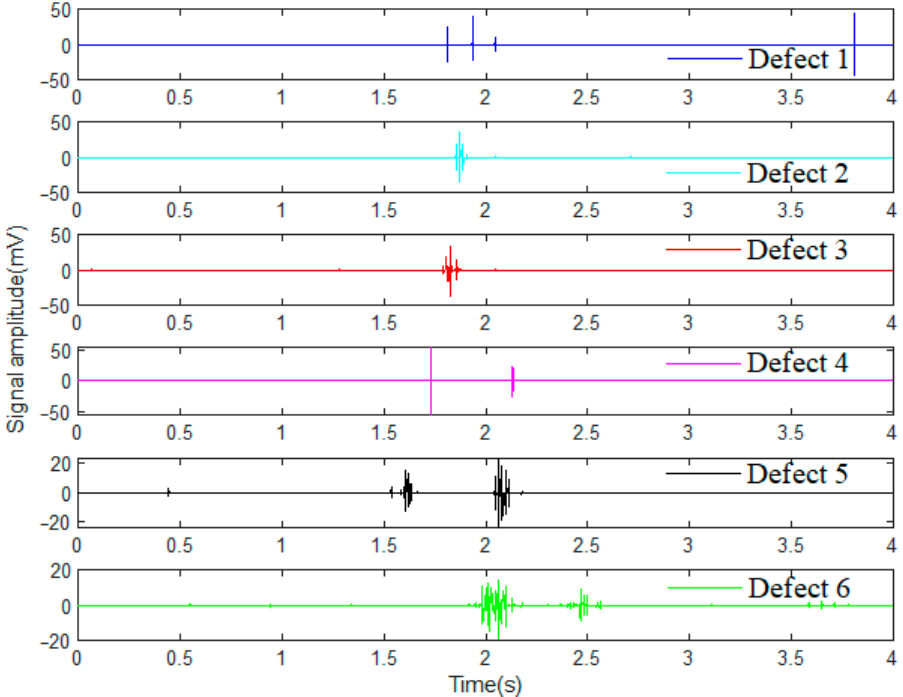
Figure 9. wire rope defect signals preprocessed by normalization. Figure 9. Wire rope defect signals preprocessed by